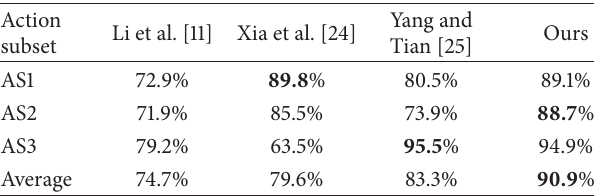
Table 4: Comparison of our method with the others on AS1, AS2,